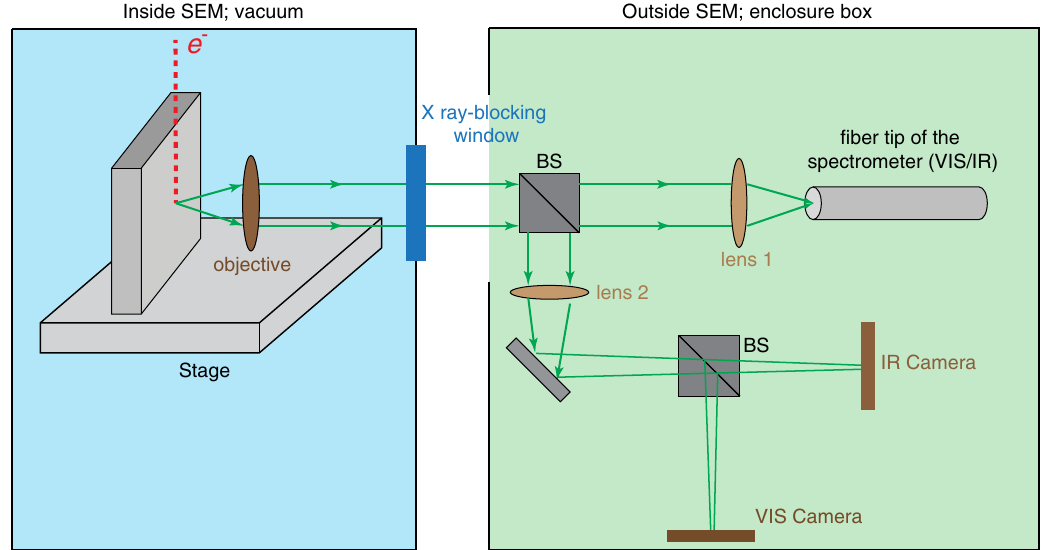
FIG. 1. Illustration of the experimental setup . The left part (shaded in blue) describes the modified stage inside the vacuum chamber of the SEM. The sample is held so that its surface is almost parallel to the path of the electron beam. The emitted light is collected by an objective, directing the emitted light into an enclosure box holding the rest of the optical setup. The right part (shaded in green) describes the optical collection setup, having a beam splitter (BS) that splits the optical beam to a fiber tip collector leading to a spectrometer (right of BS) and two CCD cameras (below the BS). Right before the spectrometer fiber, we place a polarizer. Lens 2 is used to image the surface of the sample on two CCDs. We choose between them with a flip mirror. We change among three CCDs: a visible CCD, a less-sensitive but color-visible CCD, and a near-infrared